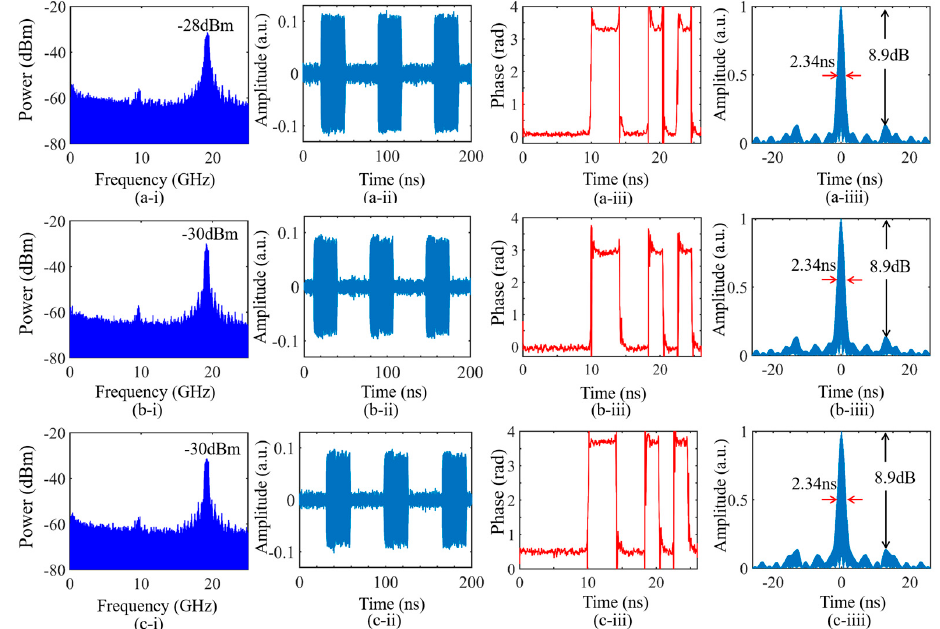
Figure 5. ( a-i ), ( b-i ), ( c-i ) Electrical spectra; ( a-ii ), ( b-ii ), ( c-ii ) temporal waveforms; ( a-iii ), ( b-iii ), ( c- iii ) corresponding phase information using Hilbert transform and ( a-iiii ), ( b-iiii ), ( c-iiii ) autocorre- lations of phase-coded microwave pulses centered at 19.2 GHz with a bit rate of 0.5 Gb/s under the Back-to-Back condition, transmitted over 10 km SMF and after 2 dB optical attenuator,